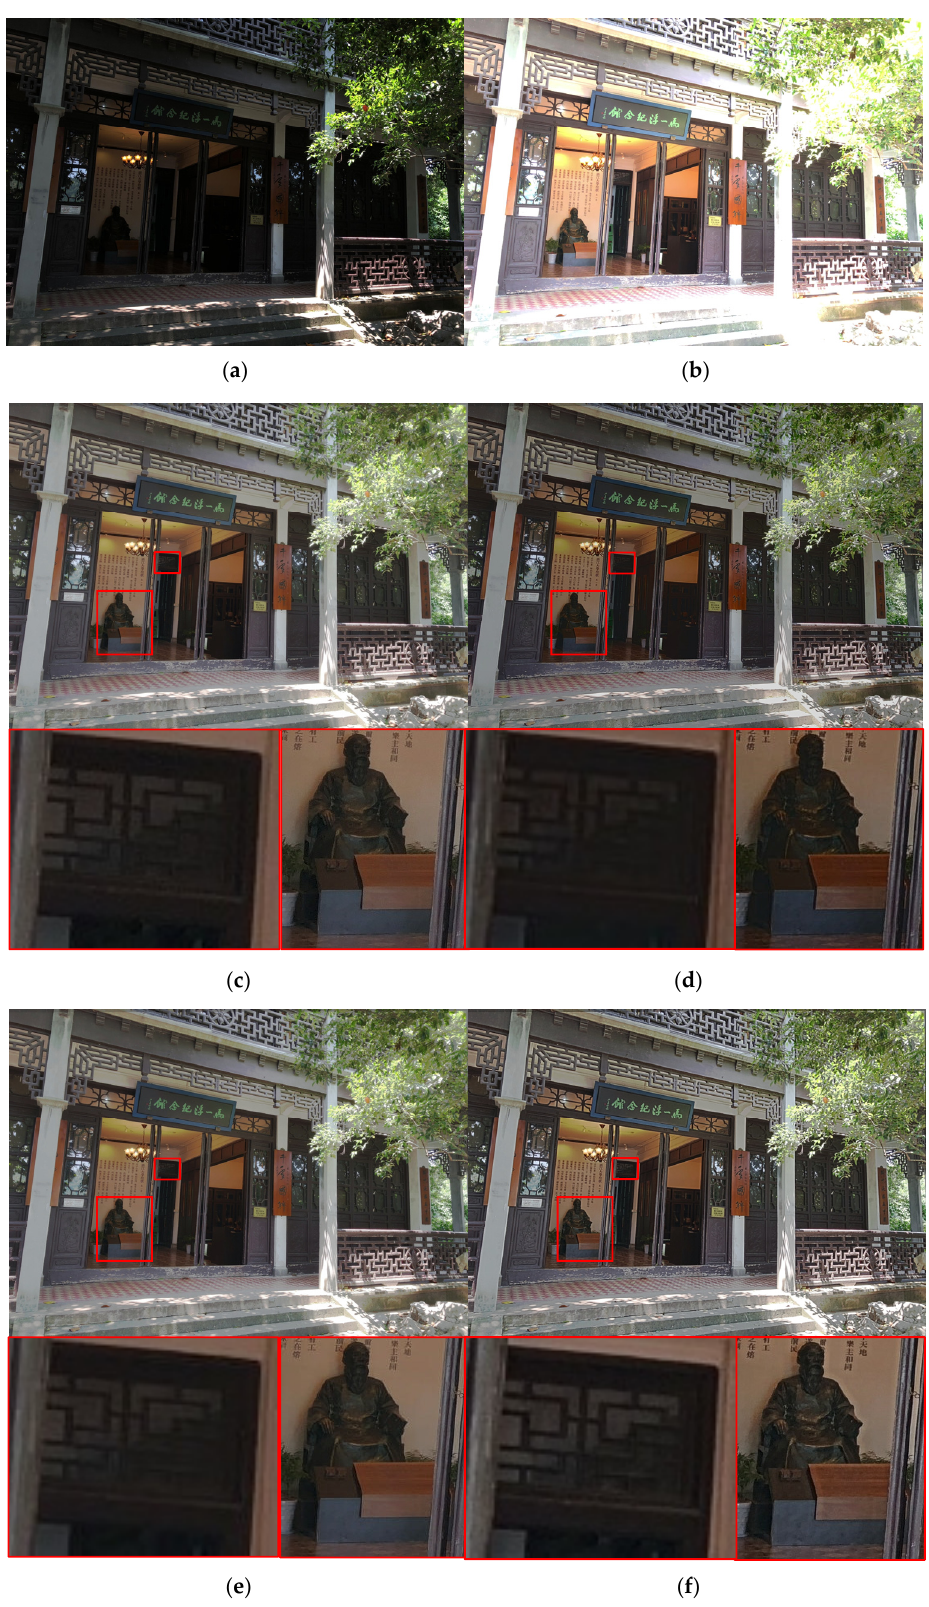
Figure 13. Input and result images (3): ( a ) Under-exposed image, ( b ) Over-exposed image, ( c ) DenseFuse, ( d ) U2Fusion, ( e ) TransMEF, ( f ) Proposed model.